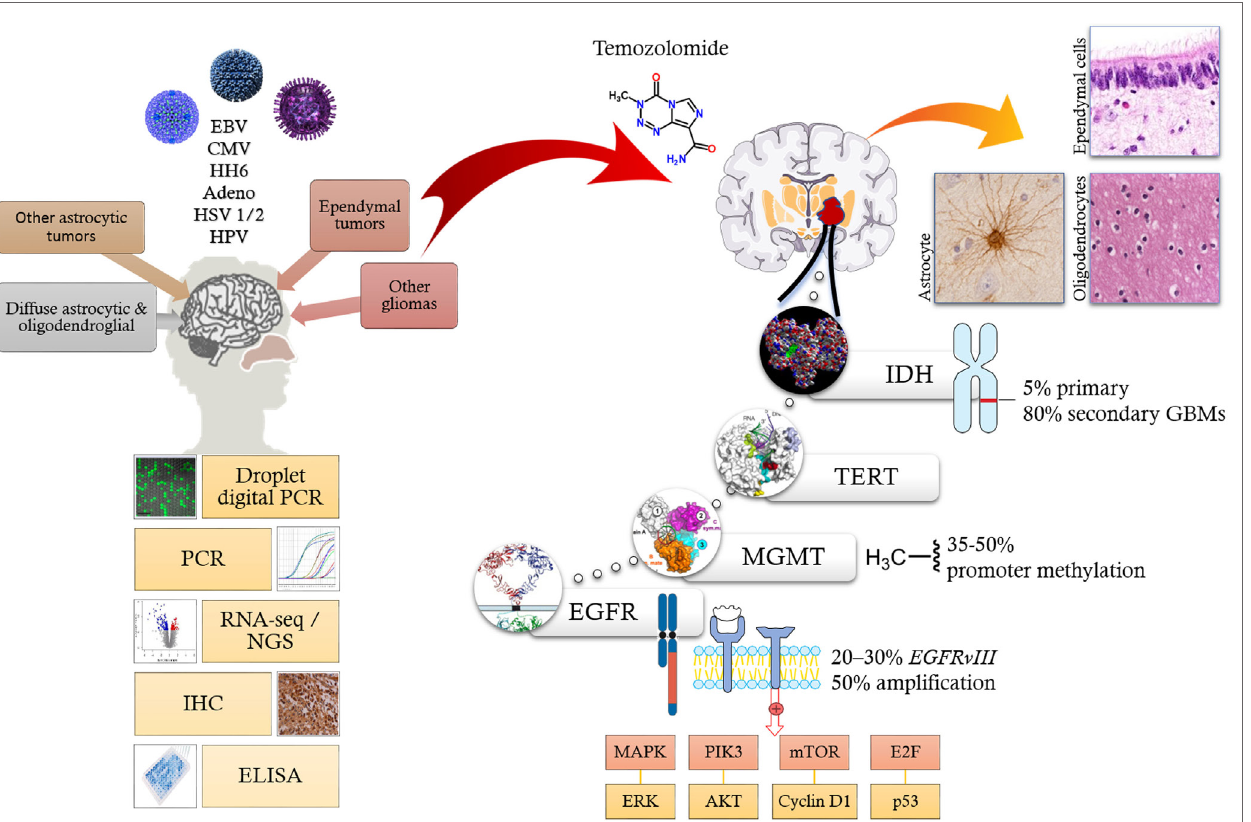
FiGURe 1 | Oncoviruses, such as EBV, CMV, HH6, adenovirus, HSV 1/2, and HPV (top left) have been linked to CNS tumors like gliomas based on various molecular biology techniques (bottom left). Current literature implicates multiple molecular pathways facilitating the formation of both low-grade and high-grade- gliomas. Signaling aberrations mainly involve EGFR amplification; metabolic alteration via IDH1; manipulation of cell cycle, DNA repair and apoptosis via tyrosine kinase signaling ERK/ATK, cyclins, E2F, and p53; epigenetic silencing of DNA repair genes like MGMT ; and activation of telomerases via mutations of TERT gene. Alkylating agents such as temozolomide alkylate/methylate, the DNA on guanine residues inducing DNA damage thereby induce apoptosis. Abbreviations: EBV, Epstein–Barr virus; CMV, cytomegalovirus; HH6, human herpes virus 6; HSV 1/2, herpes simplex virus type 1 and 2; HPV, human papillomavirus; PCR, polymerase chain reaction; RNA-Seq, RNA sequencing; NGS, next-generation sequencing; IHC, immunohistochemistry; ELISA, enzyme-linked immunosorbent assay; IDH, isocitrate dehydrogenase; TERT, telomerase reverse transcriptase; MGMT, O-6-methylguanine-DNA methyltransferase; EGFR, epidermal growth factor receptor; MAPK, mitogen-activated protein kinase; PIK3, phosphatidylinositol 3-kinase; mTOR, mechanistic target of rapamycin; ERK, extracellular signal-regulated kinases.